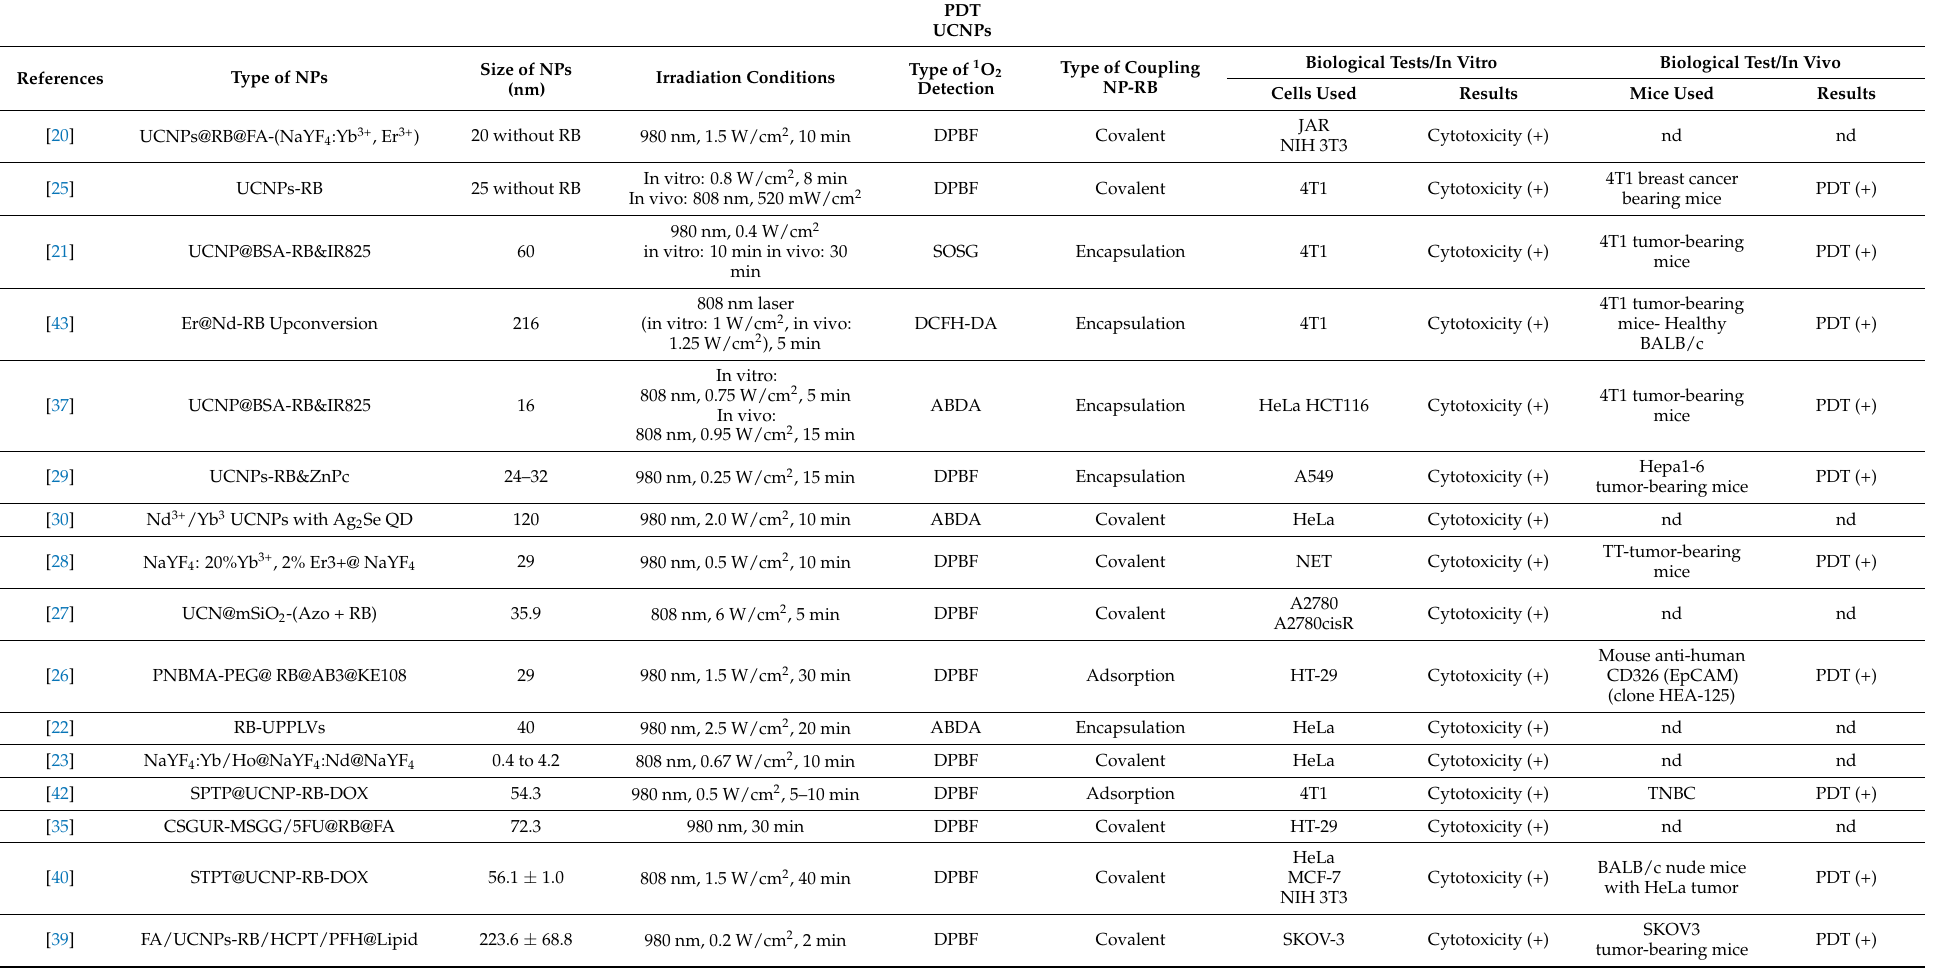
Table 1. Table summarizing all references dealing with UCNP@RB, including type of NPs, along with their size, excitation wavelength, type of detection of 1 O 2 , type of coupling between the NPs and the RB, and an indication of the type of biological tests performed. PDT